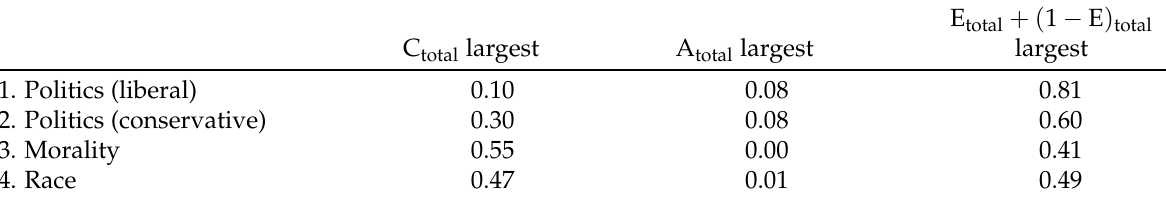
Table 4: Proportion of respondents for whom C are largest